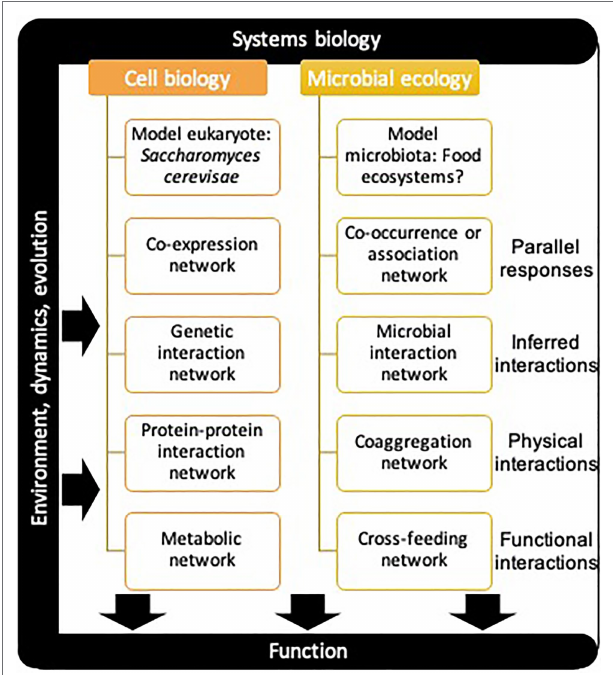
FIGURE 4 | Parallel between systems biology approaches in cell biology and microbial ecology. Different relationship types can be considered between the systems components at both the cellular and community level to make up various